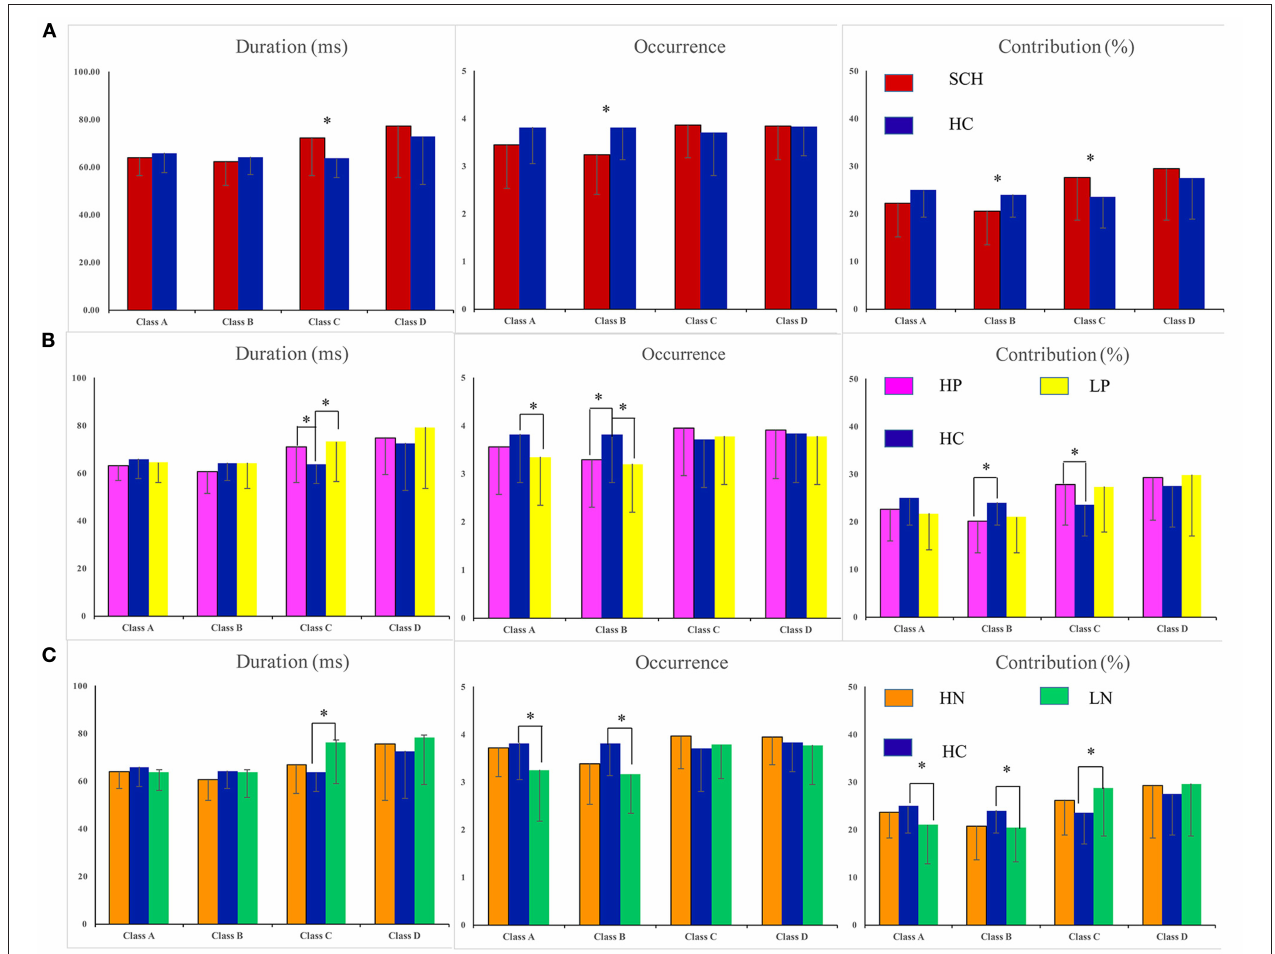
FIGURE 2 | Statistics of the microstate parameters: duration, contribution, and occurrence. * P < 005. Errror bars represent standard error. SCH, individuals with schizophrenia; HC, healthy controls; HP, schizophrenia patients with high levels of postive symptoms; LP, schizophrenia patients with low levels of postive symptoms; HN, schizophrenia patients with high level of negative symptoms; LN, schizophrenia patients with low lwvwl of negative symptoms. (A) SCH vs. HC. (B) Comparisions were made between groups (HP vs. HC, LP vs. HC). (C) Comparisons were made between groups (HN vs. HC, LN vs.